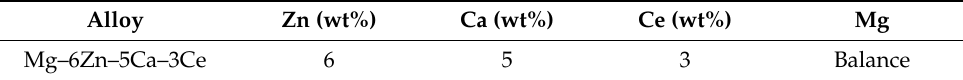
Table 1. Nominal chemical composition of RS Mg–6Zn–5Ca–3Ce alloy.